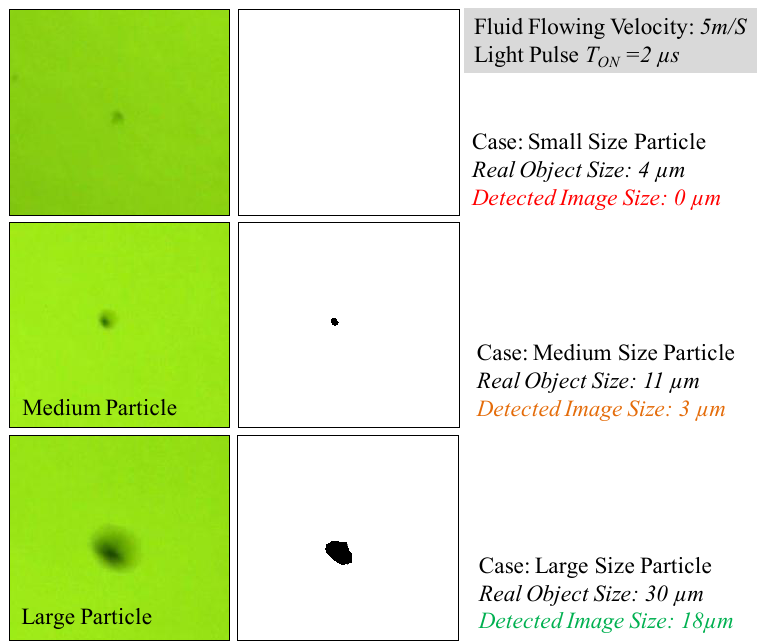
Figure 15. CFD simulation of sensor fluidic structure displaying the flowing velocity of the lubricant normalized to 1 m/s.